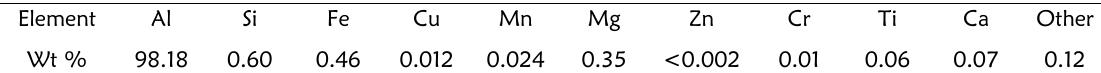
Table 1: Chemical composition of aluminium (Al 6063) off-cut [12]